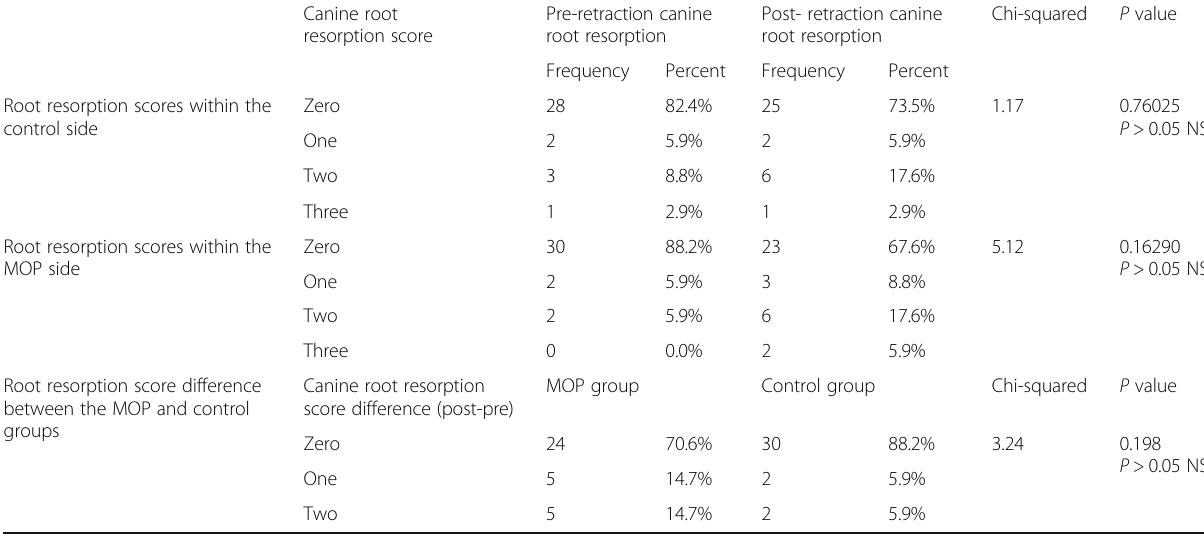
Table 2 Canine root resorption scores (chi-squared test)